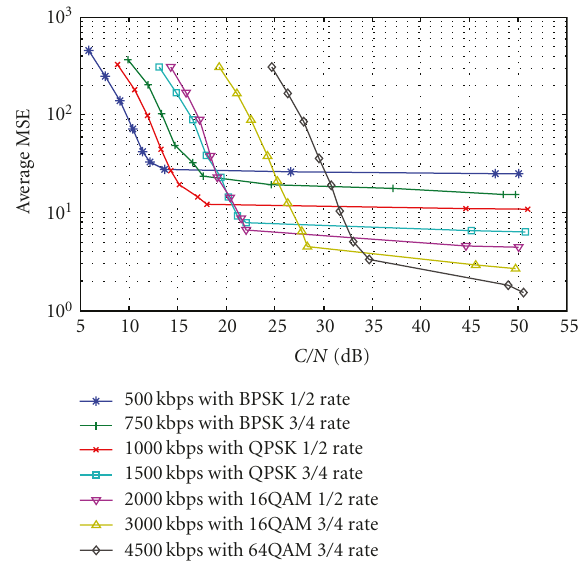
Figure 6: Distortion-based link adaptation, foreman , NAL unit max size: 750